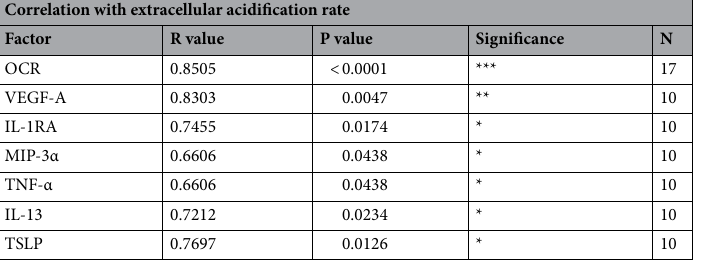
dendritic cells, as this could hinder clinical potential. Patient information is outlined in Supplemental Table 3. Monocyte-derived immature dendritic cells were pre-incubated with either 0.1% DMSO, 10 µM pyrazinib (P3),